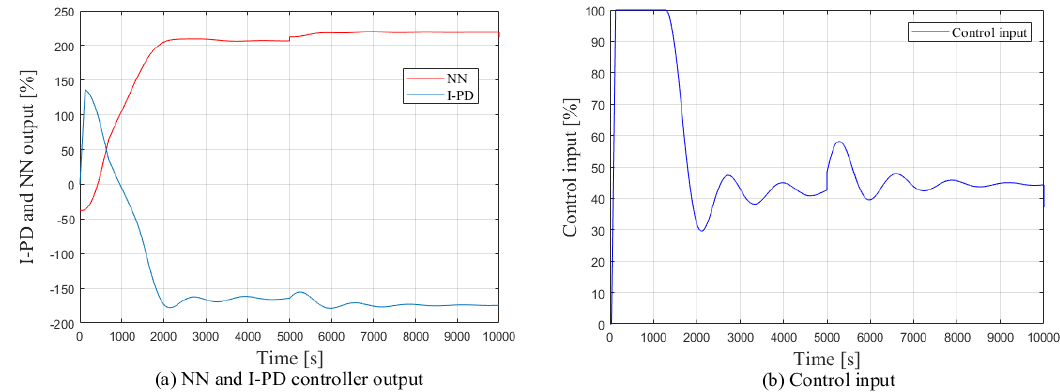
Figure 8. ( a ) Outputs of ANN controller and I-PD controller and ( b ) control input obtained from